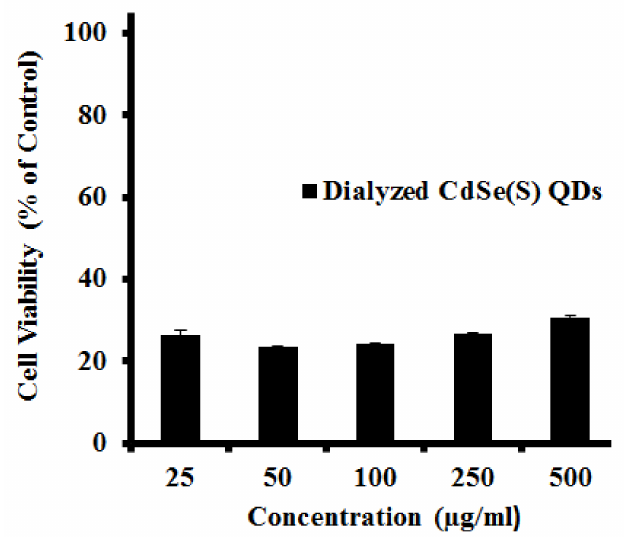
Figure 6. The results of cytotoxicity assays of dialyzed CdSe(S) QDs towards human colorectal carcinoma cells (HCT-116). Error bars indicate standard error of the mean and cell media without treatment with QDs was used as a